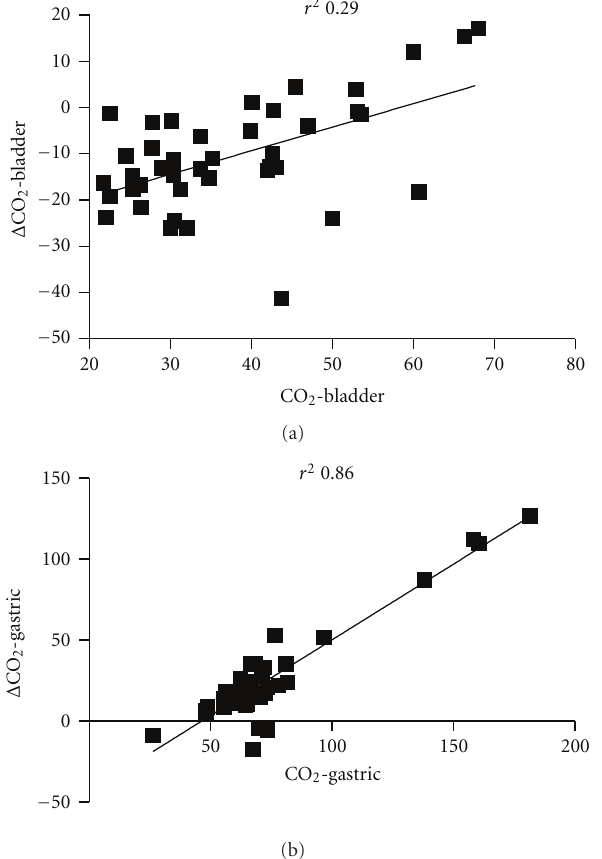
Figure 3: Correlation between mucosal CO 2 and Gap between mucosal and arterial CO 2 . Figure 4: Correlation between mucosal (gastric and bladder) CO